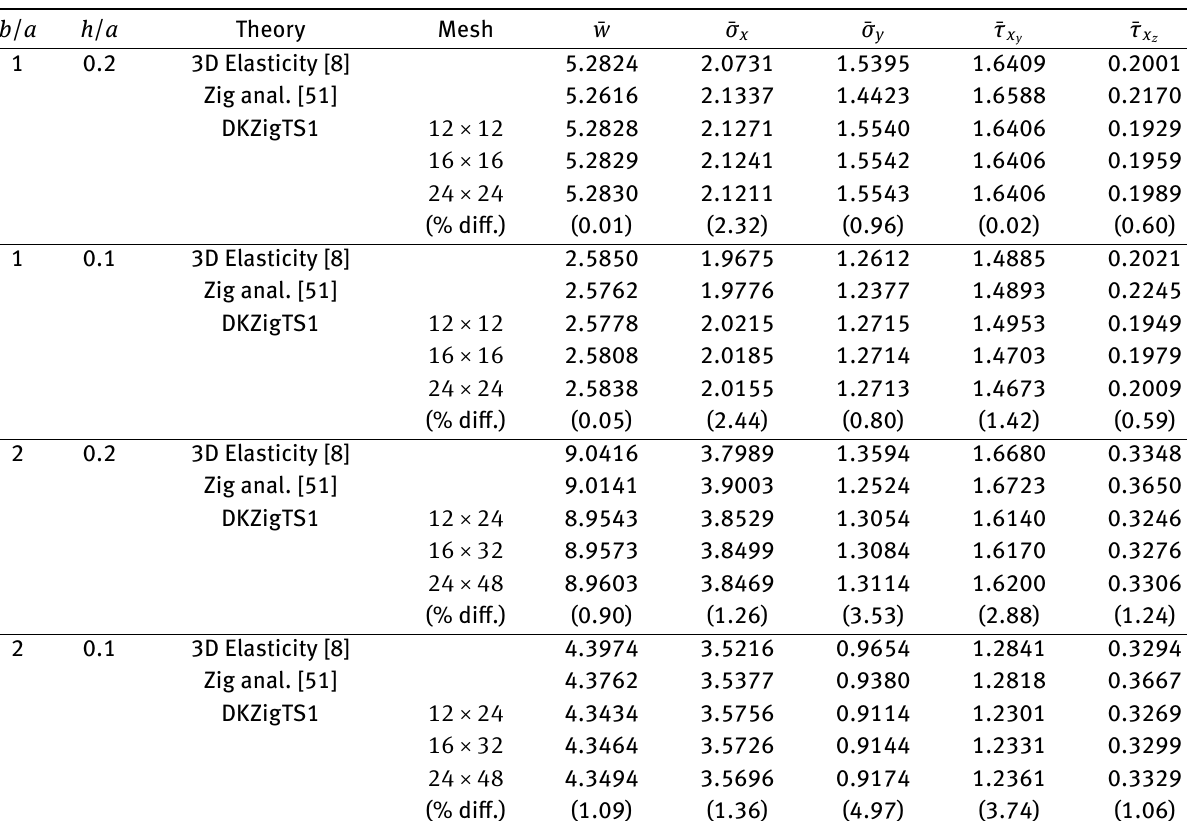
Table 11: Non-dimensionalised central deflection and stresses for an all-round simply supported sandwich cylindrical shell panel ’E’ with b / a = 1 & 2 , R / a = 2 under sinusoidally distributed load